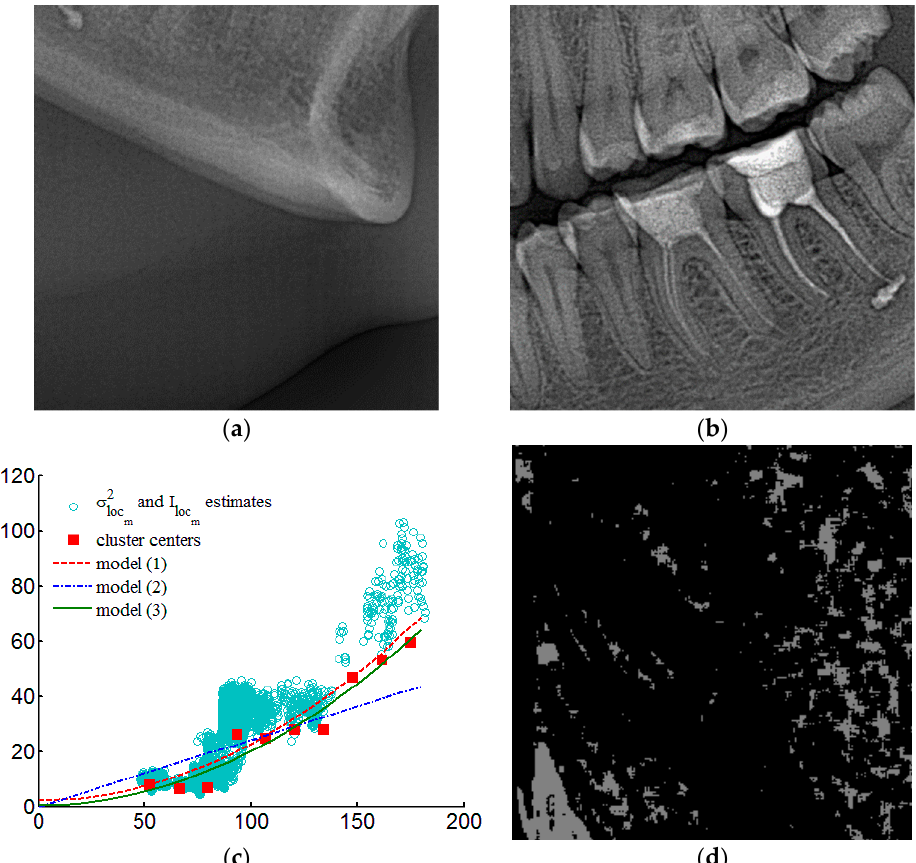
Figure 1. The 512 × 512 pixel fragments of different context ( a , b ) and scatterplot of local variance estimates ( c ) for homogeneous regions (( d ), gray color) of the fragment in ( a ).